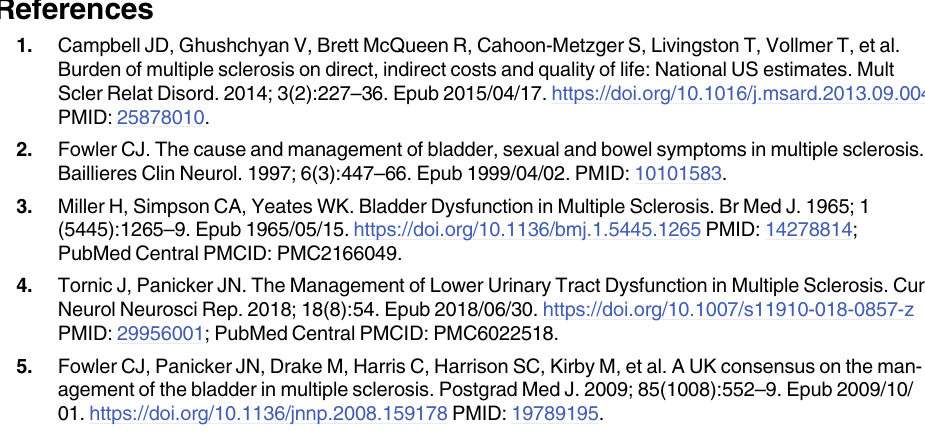
S2 Table. Expression of the genes in spinal cord specimens from CIE 4 wks mice grouped by signaling pathways. S3 Table. Expression of the genes in the urinary bladder of mice from CIE 1 wk group based on signaling pathways. S4 Table. Expression of the genes in urinary bladder specimens of CIE mice at 4 wks after infection grouped by signaling